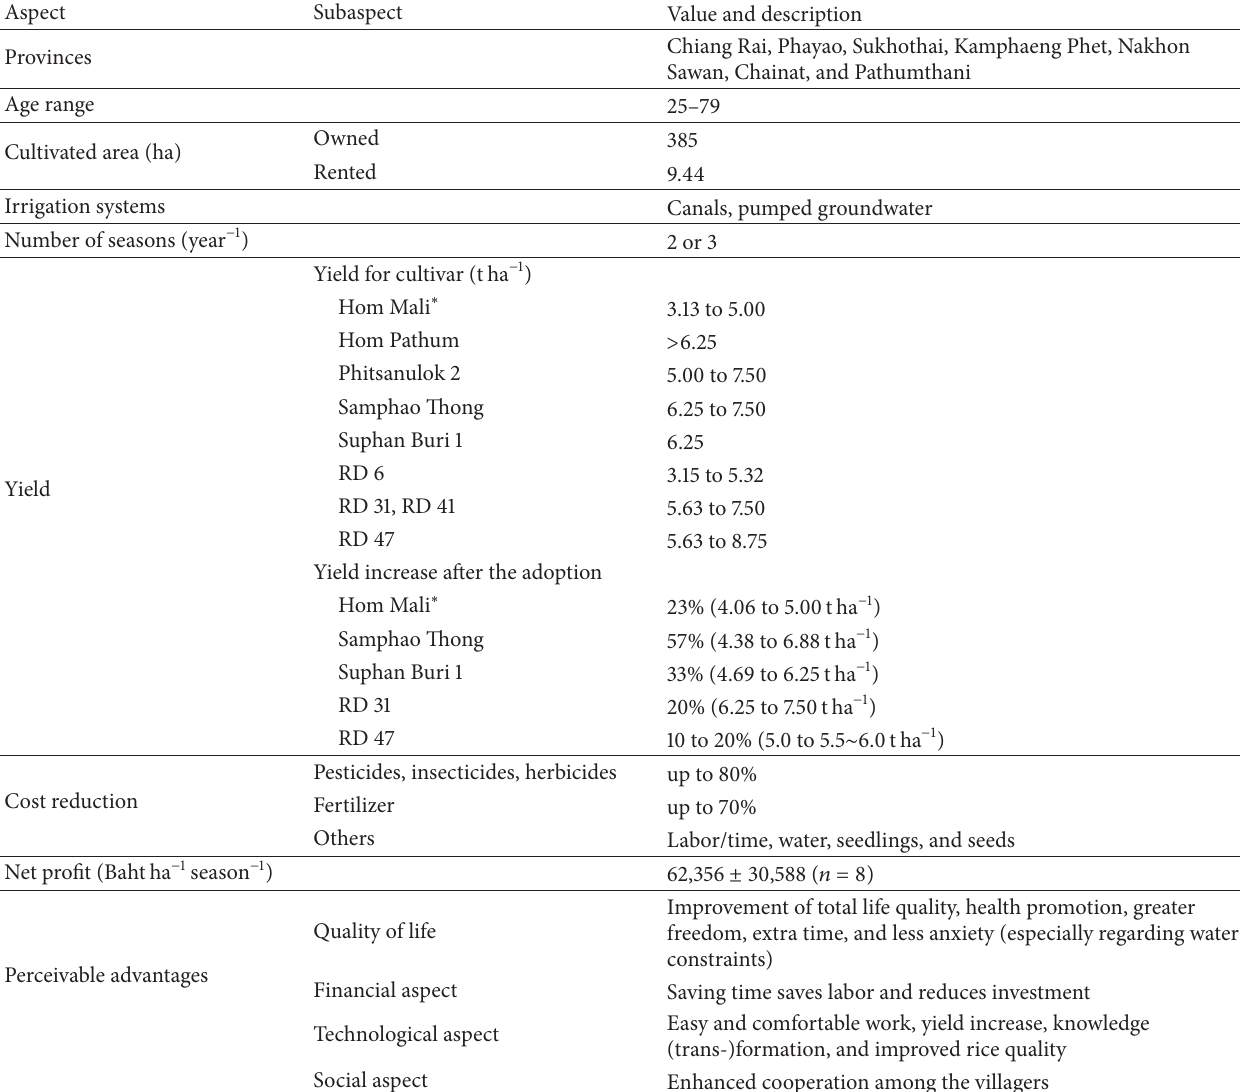
Table 2: Summary of interviews conducted at the